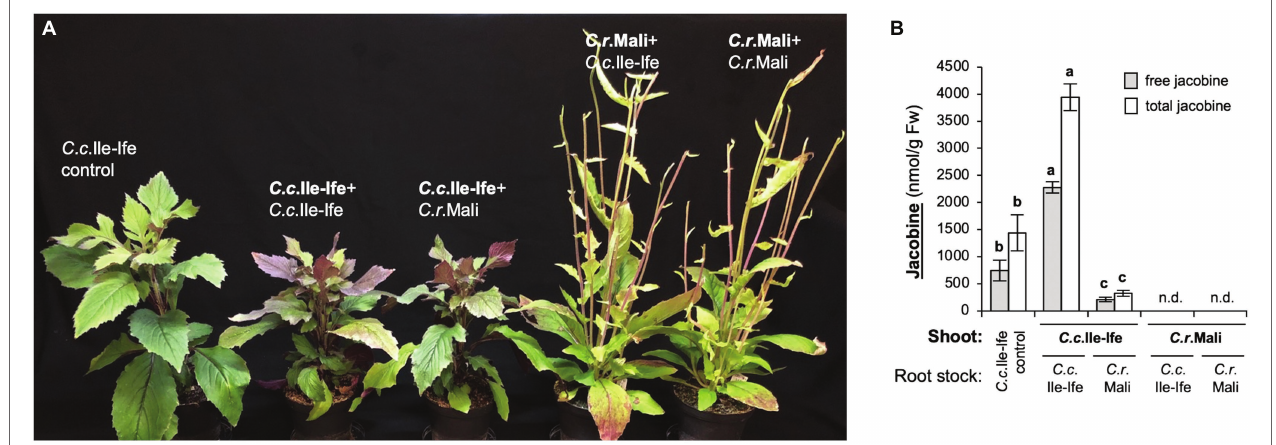
FIGURE 4 | Jacobine accumulation in Crassocephalum crepidioides relies on its shoot organs. Two-week-old scions of C.c. Ile-Ife were grafted onto root stocks of C.r. Mali and vice versa and maintained in tissue culture for 1 week for establishment. Grafted plants, grafting controls (scions united with rootstocks of the same species) and non-grafted C.c. Ile-Ife plants (as a control) where then transferred to SP ED63 (low nitrate) substrate and grown for another 11 weeks in standard growth conditions, before free and total jacobine was measured in shoots. (A) Pictures of representative plants. The grafting combinations are named with the shoot in first position (in bold letters) and the root stock in second position. (B) Levels of free and total jacobine in nmol/g Fw. Plants are labeled like in A (shoot donor in bold). The columns and bars represent the average and standard error of 6–17 independent replicates. Statistically significant difference at p ≤ 0.05 of results is indicated with different letters and was determined with one-way ANOVA followed by Tukey’s HSD test (free jacobine: ANOVA F 2,30 = 164.719, p < 0.0001; total jacobine: ANOVA F 2,30 = 130.194, p < 0.0001). n.d. (not detected): below the detection limit of 4 nmol/g